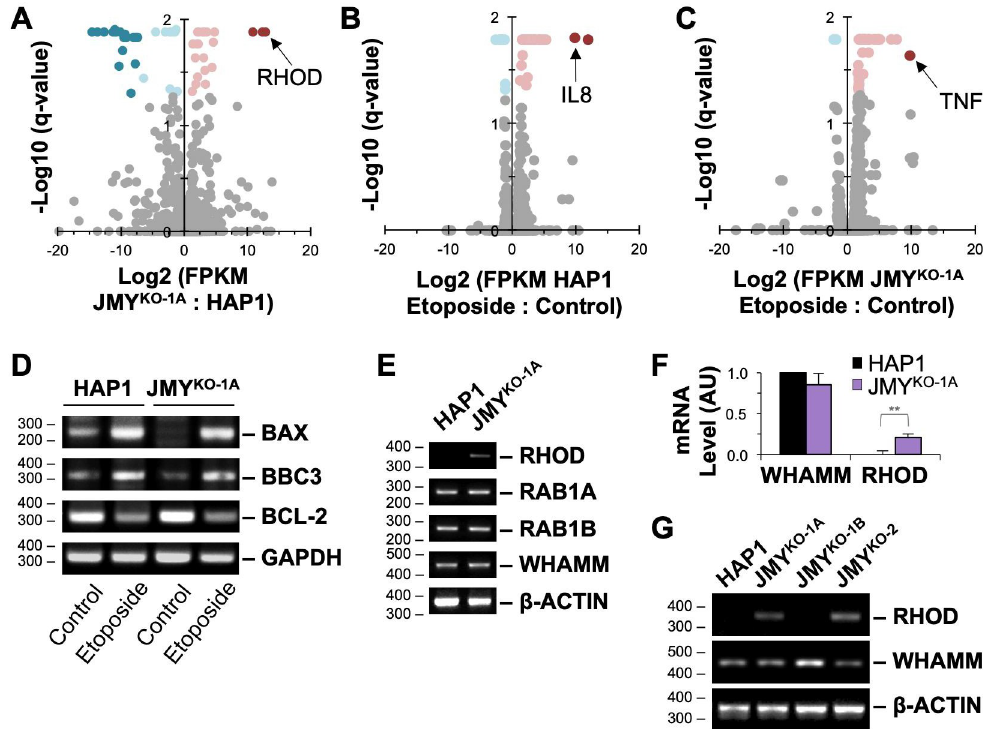
Fig 6. Expression of RHOD , but not canonical apoptosis regulators, is turned on in JMY-knockout cells. (A) RNA collected from HAP1 and JMY KO-1A cells was subjected to mRNA sequencing analysis. A volcano plot represents FPKM (Fragments Per Kilobase of transcript per Million mapped reads) values plotted against -log10(q-values) of all individual genes for JMY KO-1A vs HAP1 cells. Genes with expression differences of at least 2-fold and with a significance q-value of < 0.05 are shown in dark red (turned on), pink (up-regulated), light blue (down-regulated), or dark blue (turned off), while genes that do not meet these criteria are depicted in gray (unchanged). Each point represents the mean value from 3 independent RNA samples per genotype. (B-C) RNA collected from HAP1 and JMY KO-1A cells treated with 5 μ M etoposide for 6h was subjected to mRNA sequencing. Volcano plots represent FPKM values plotted against -log10(q-values) of all individual genes for etoposide vs control media-treated HAP1 (B) or JMY KO (C) cells. Genes with expression differences of at least 2-fold and with a significance q-value of < 0.05 are shown as in A. Each point represents the mean value from two independent RNA samples per genotype, except for IL8 , which was only detected in one experiment. (D-E) RNA from HAP1 and JMY KO cells was subjected to RT-PCR using primers to BAX , BBC3 , BCL-2 , GAPDH , RHOD , RAB1A , RAB1B , WHAMM , and β -ACTIN , and visualized on agarose gels. (F) Gel band intensities were quantified in ImageJ, and values for RHOD and WHAMM were normalized to β -ACTIN . AU = Arbitrary Units. Each bar represents the mean ± SD from 3 experiments. (G) RNA from HAP1, JMY KO-1A , JMY KO-1B , and JMY KO-2 cells were subjected to RT-PCR and visualized on agarose gels. �� p < 0.01